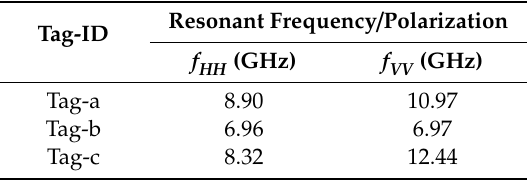
Table 1. Unique frequency signature of single tag letters from Figure.